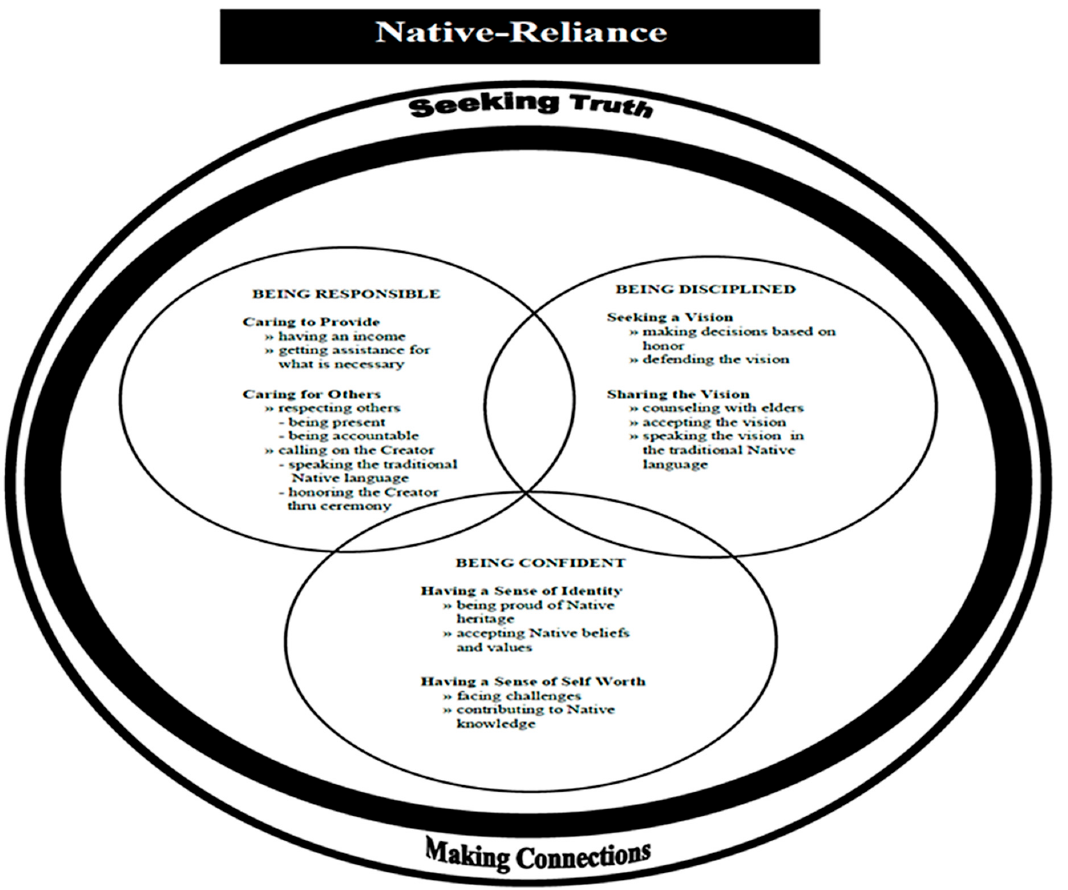
Figure 1. Native-Reliance Theory and guiding framework.